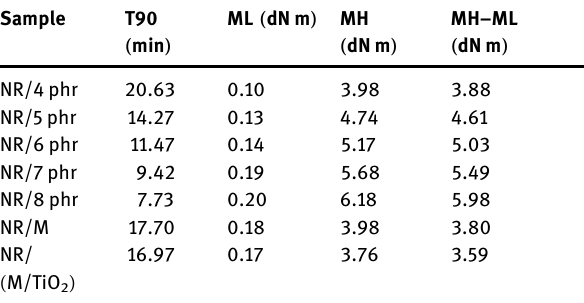
Table 3: The curing parameters of natural rubber compounds